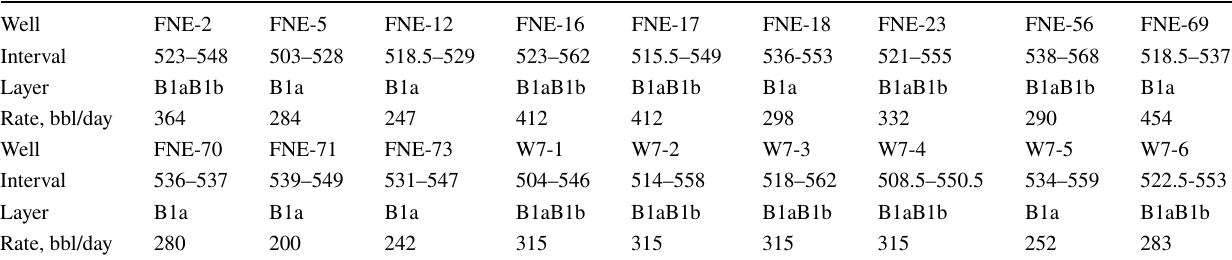
Table 16 Liquid rate of producers in recommended case